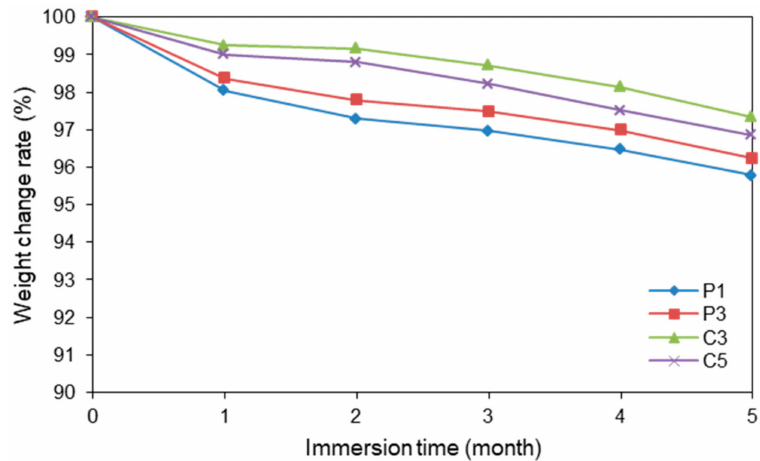
Figure 8. Rates of weight change of various fibers in PBS.